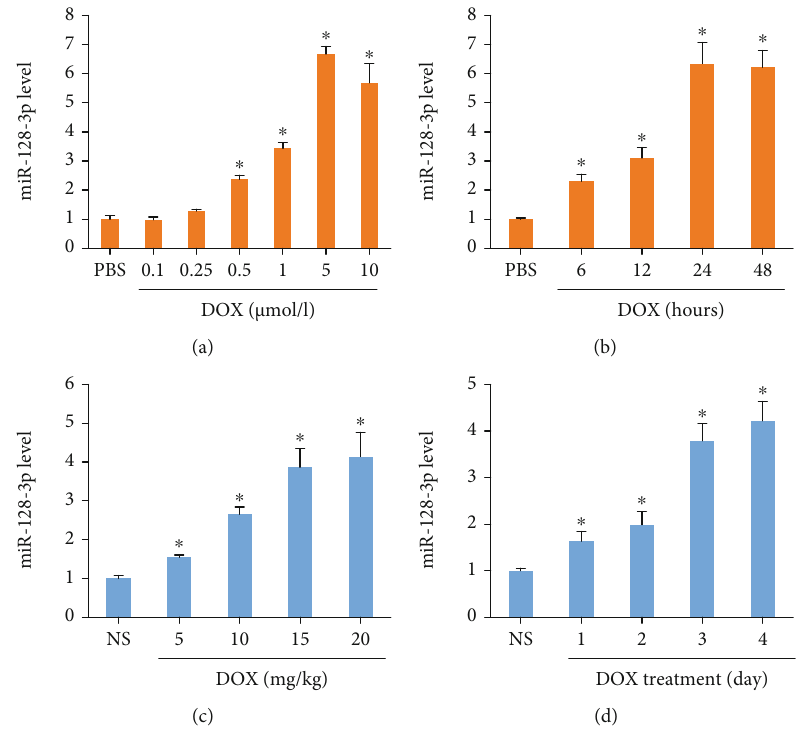
Figure 1: DOX decreased miR-128-3p expression. (a, b) The level of miR-128-3p expression in DOX-treated cells ( n = 6 for each points). (c, d) The level of miR-128-3p expression in DOX-treated hearts ( n = 6 for each points). Data are expressed as mean ± SEM . ∗ P < 0 : 05 vs. NS or PBS